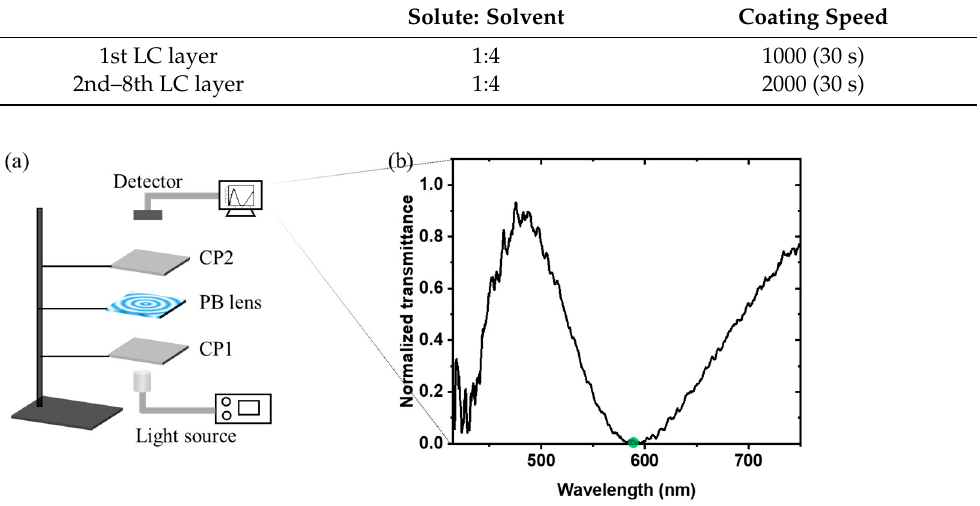
Figure 2. ( a ) Transmittance measurement setup. CP: circular polarizer. ( b ) Measured normalized transmission spectrum of the PB lens sandwiched between two CPs.